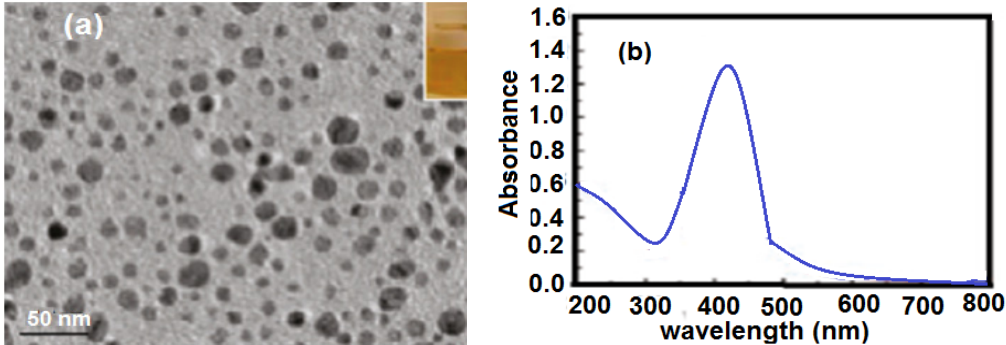
Figure 3. Set of images for silver nanoparticles: ( a ) TEM image of the citrate AgNP and ( b ) its UV-Vis absorption